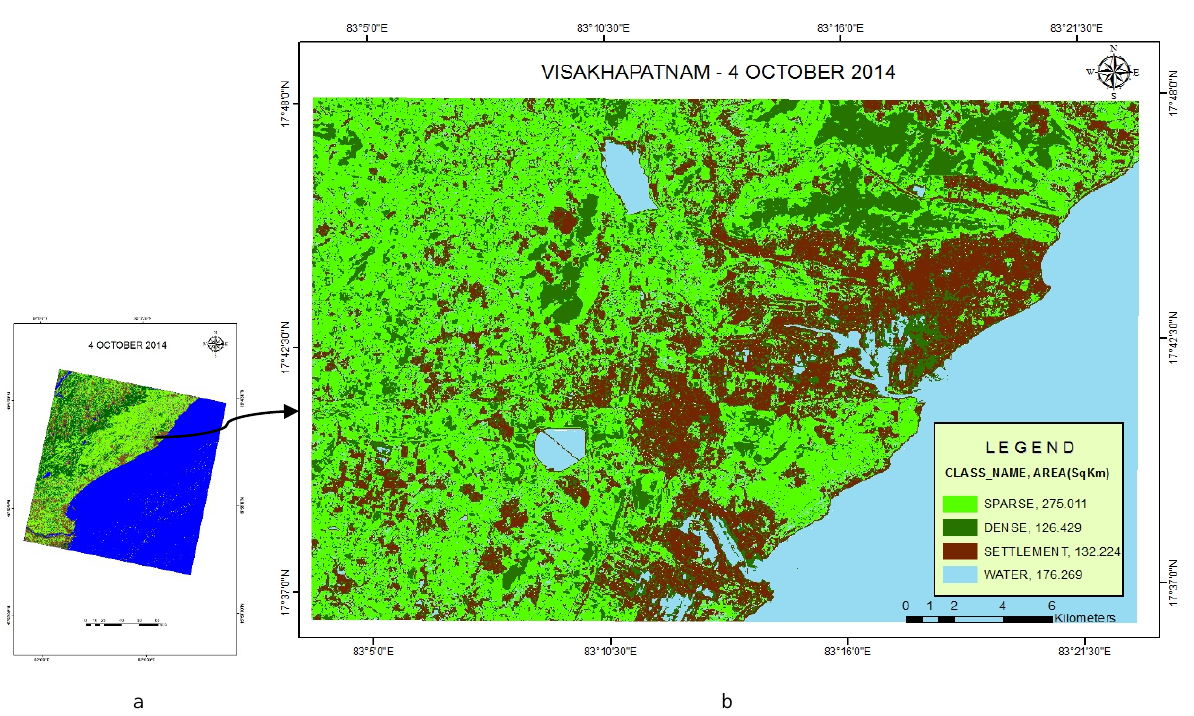
Figure 6. (a) NDVI Classification Map (b) Study area is clipped from the NDVI Classification